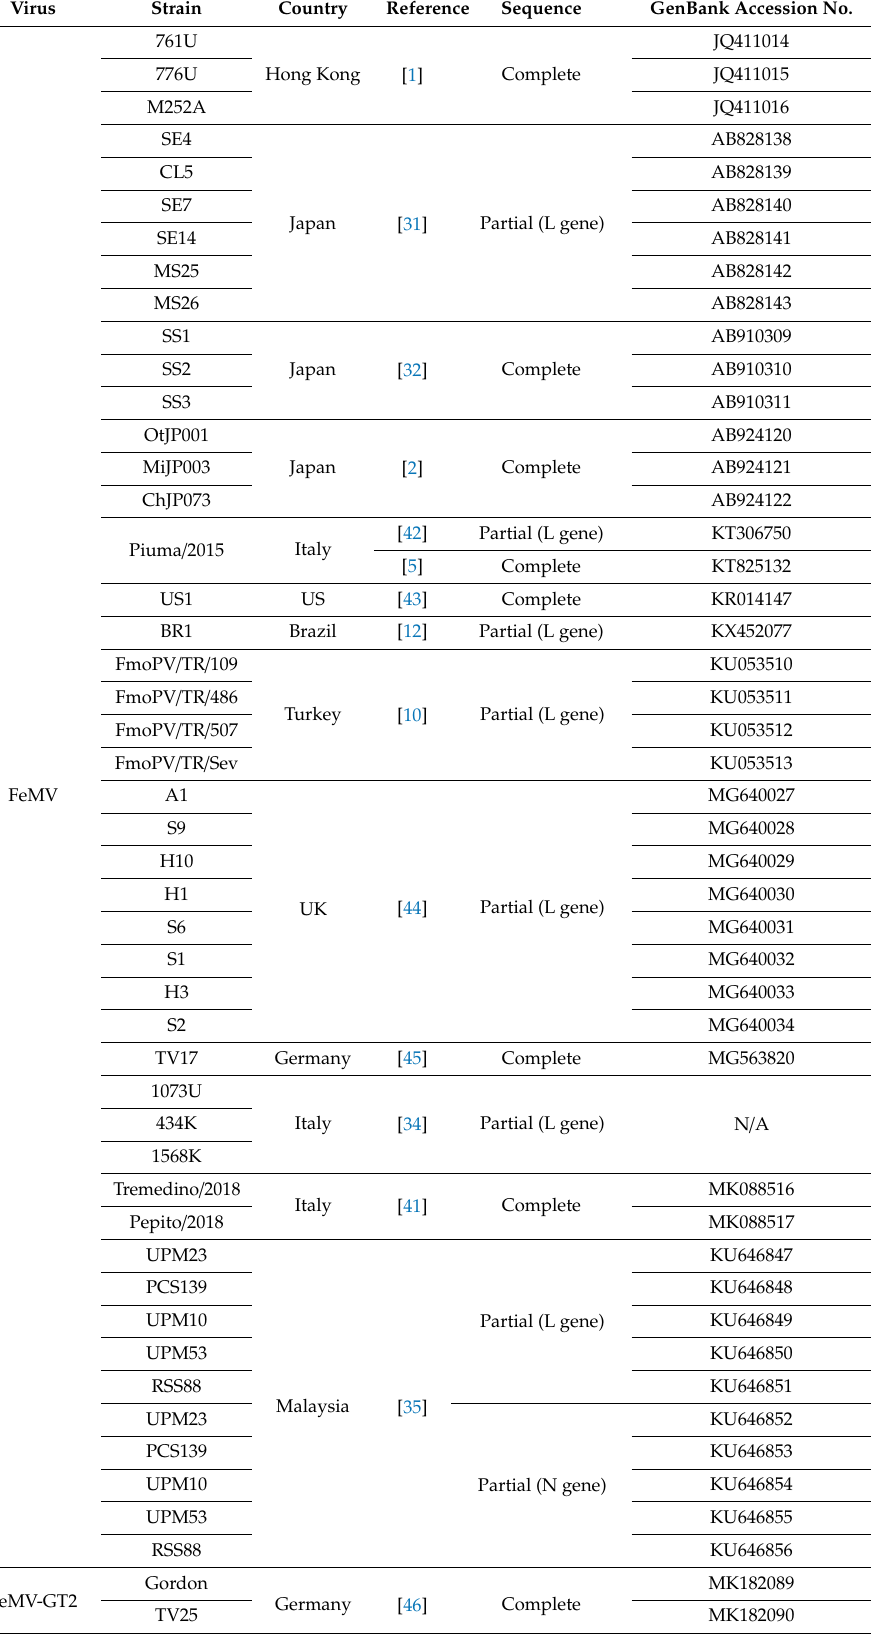
Table 1. Reported FeMV complete / partial